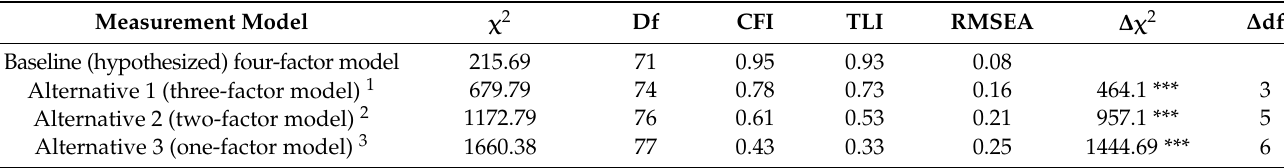
Table 2. Model fit statistics for the measurement